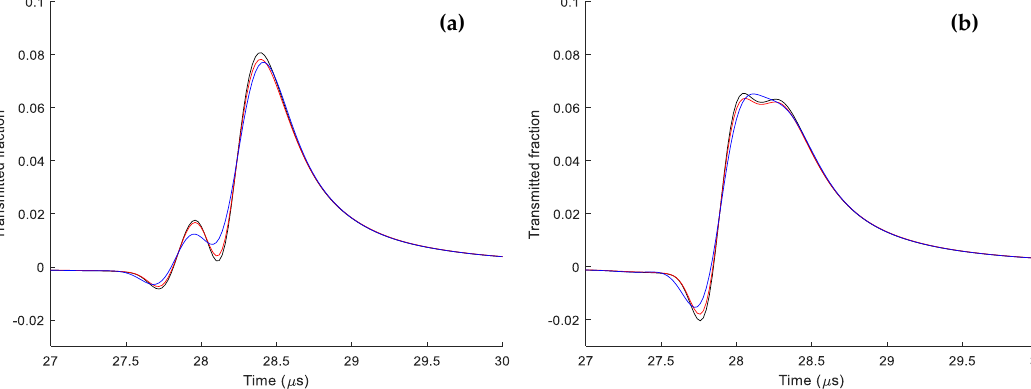
Figure 8. Waveforms for unbalanced current with one phase 20% higher ( a ) or 20% lower ( b ) current than average; injection and detection take place in one of the other phases carrying equal currents; blue, red and black curves correspond to measured, constant and no imaginary permittivity, respectively.